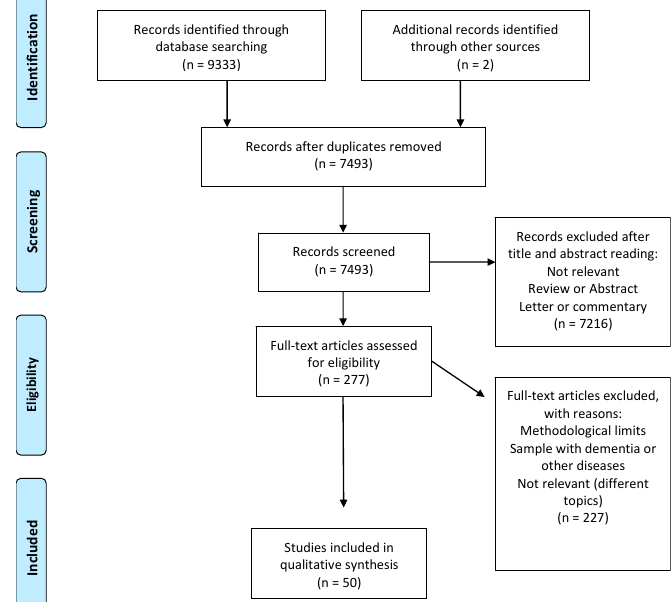
Figure 1. PRISMA flow chart of the selection process.